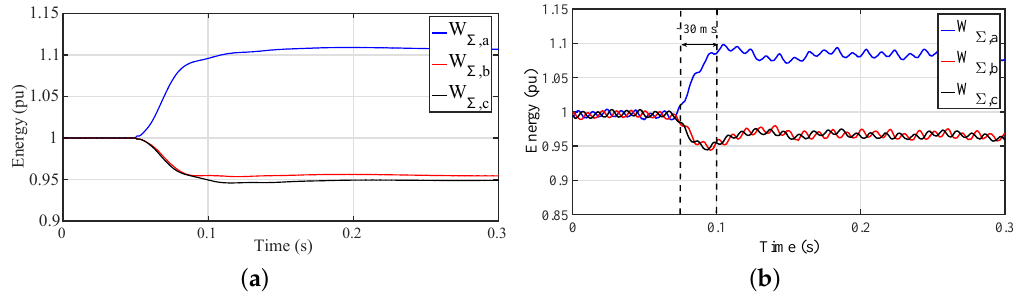
Figure 9. Leg energy controller step response ( a ) in simulation and ( b ) experimental performance.